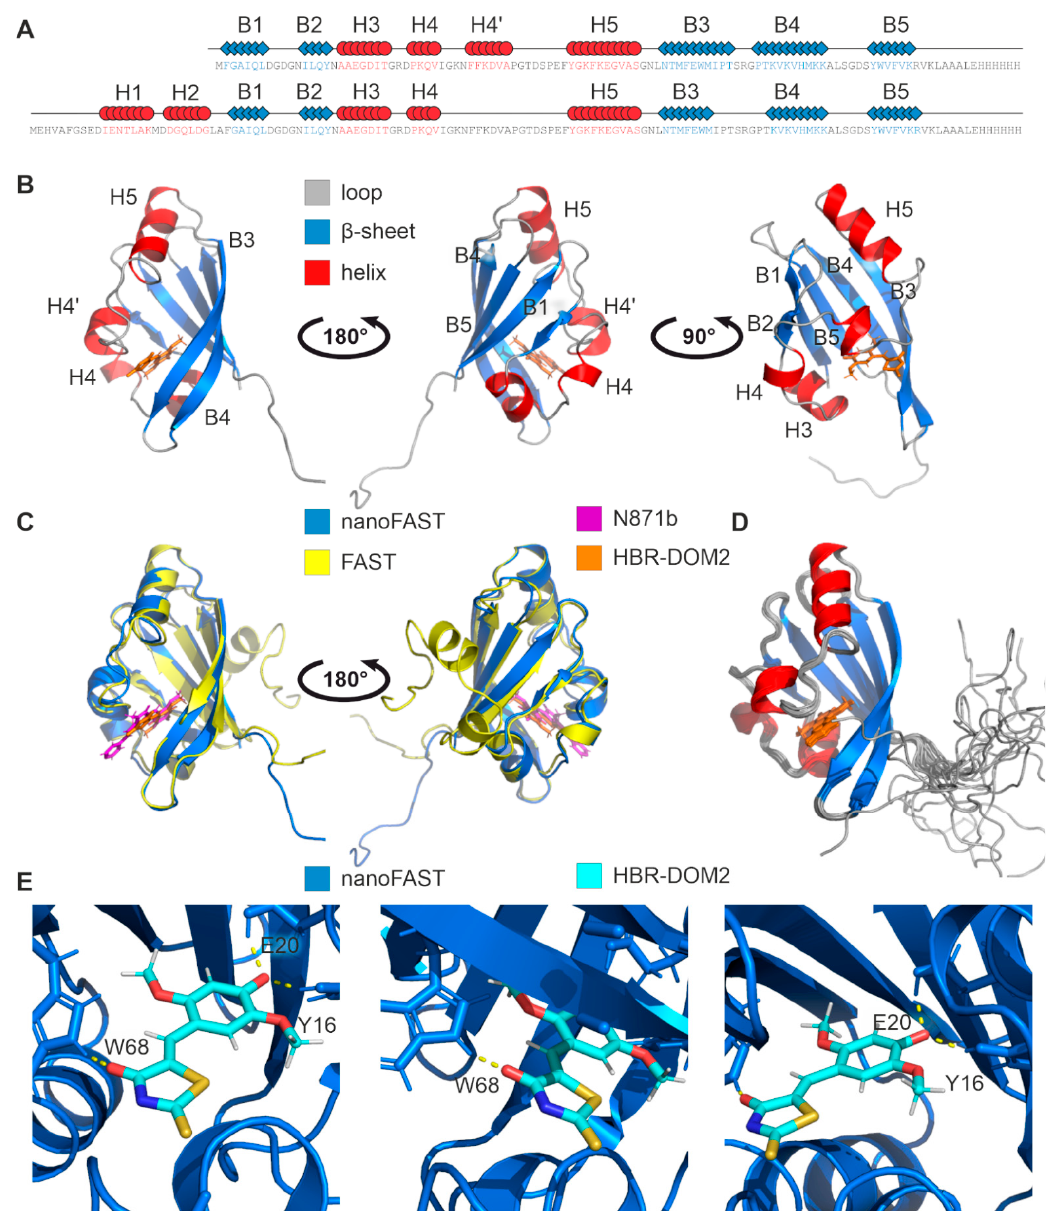
Figure 2. Spatial structure of nanoFAST/HBR-DOM2 complex. ( A )—Secondary structure of nanoFAST/HBR-DOM2, comparison with FAST/N871b. α -helixes are shown in red, β -sheets are shown in blue. ( B )—Structure of nanoFAST/HBR-DOM2 in ribbon representation. H1–H5 and B1–B5 stand for the elements of secondary structure, α -helices and β -strands, respectively. Numbering corresponds to the structure of the ligand-bound full-length FAST protein. ( C )—Comparison of spatial structures of nanoFAST/HBR-DOM2 (blue/orange) and FAST/N871b (yellow/magenta). ( D )—Twenty best structures of nanoFAST/HBR-DOM2, superimposed over the backbone atoms of the secondary structure elements. α -Helices are colored in red, β -sheets are shown in blue, coil regions are shown in gray. ( E )—Spatial structures of nanoFAST/HBR-DOM2 with the zoom at the in- termolecular hydrogen bonds. Ligand molecule is painted according to the atom type (carbon—cyan, nitrogen—blue, oxygen—red, and